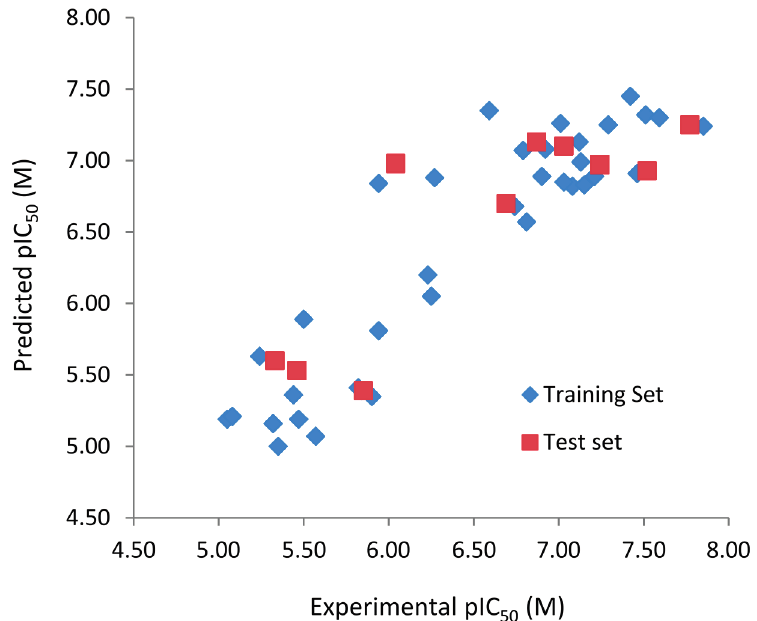
Figure 2. Experimental vs. predicted pIC 50 values of the training (blue) and test (red) sets obtained using the best model with the fragment distinction parameters A/B